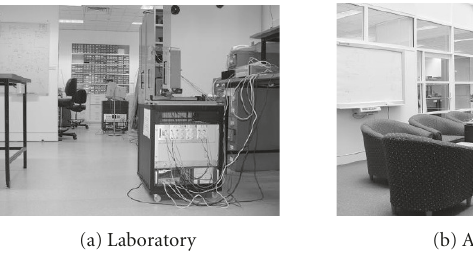
Figure 2: Photographs of measurement